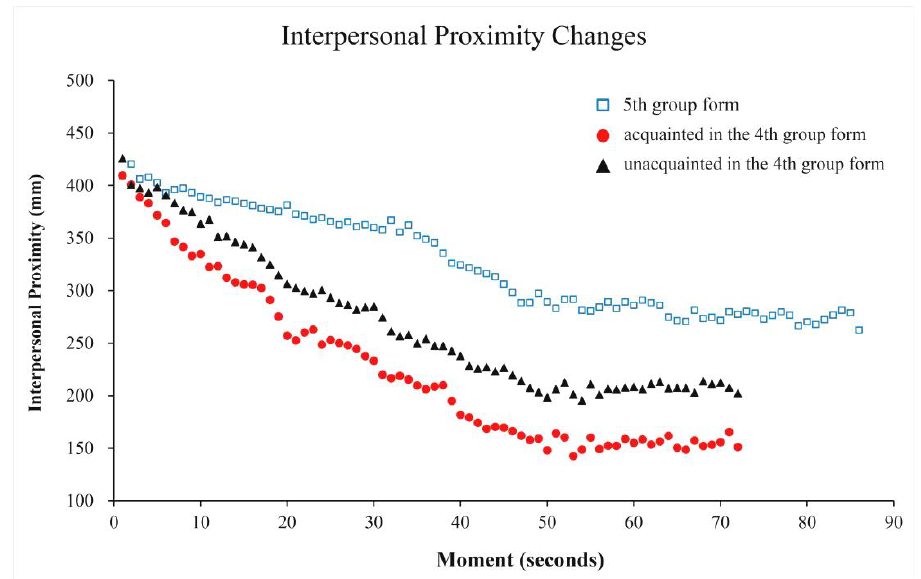
Figure 4. An example of the interpersonal proximity changes throughout the task in the 4th and 5th group forms.